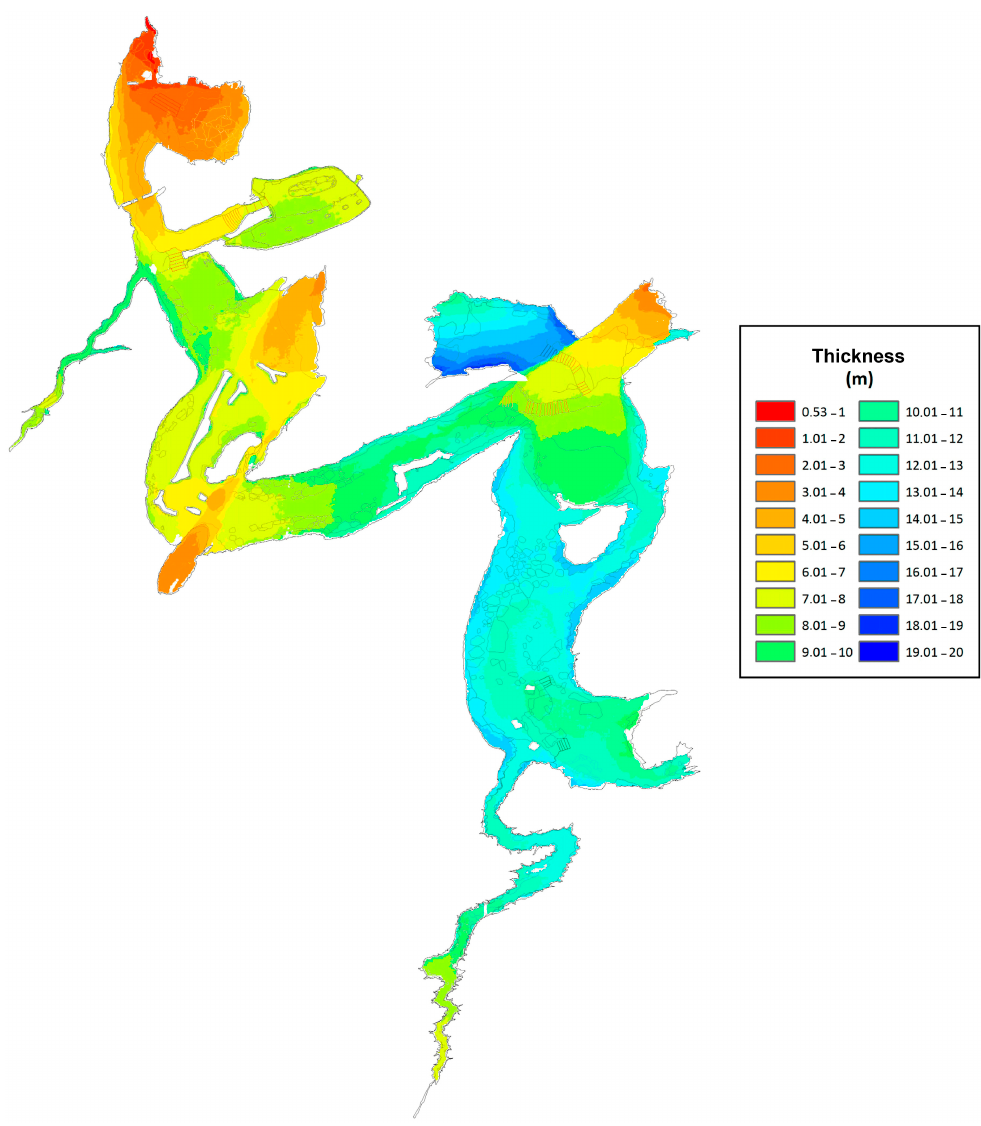
Figure 11. Overlying layer thickness model of Altamira Cave.